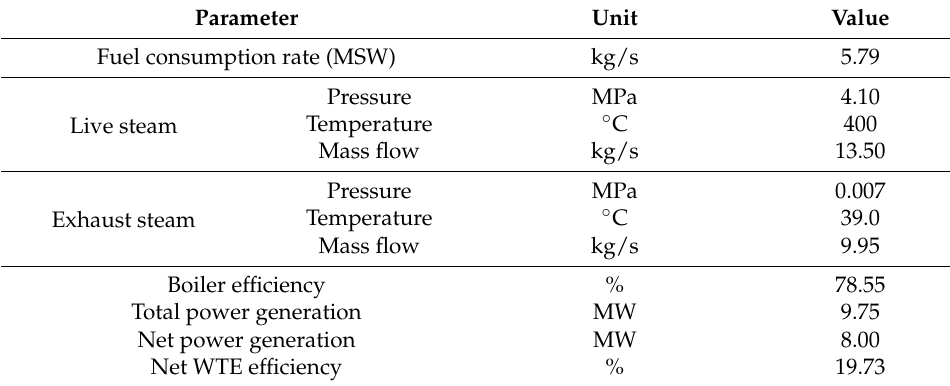
Table 2. Operating parameters of the